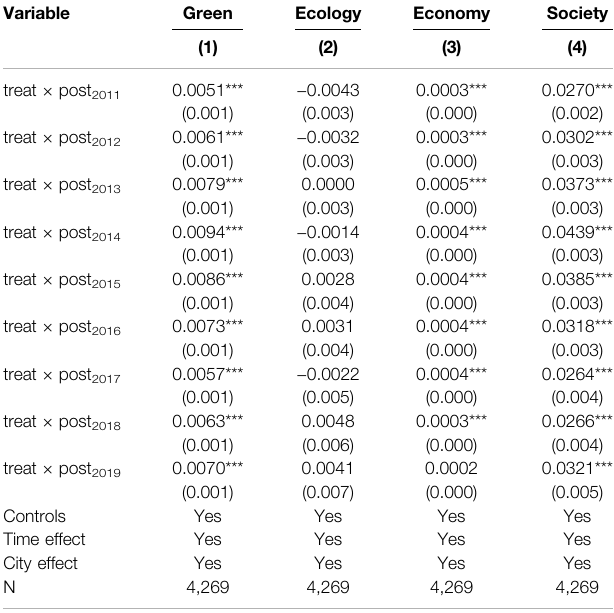
TABLE 5 | The dynamic effect test of STFP on green development.